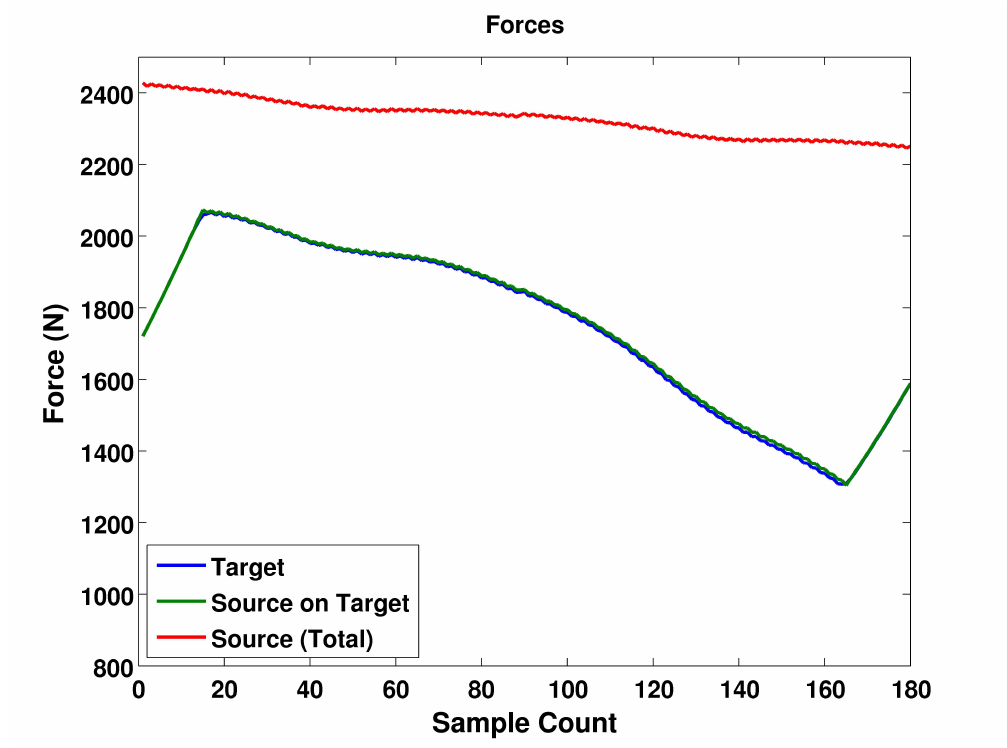
Figure 4. Comparison of the Total Forces in Newtons of the source versus the target, for 180 different source pressure profiles.